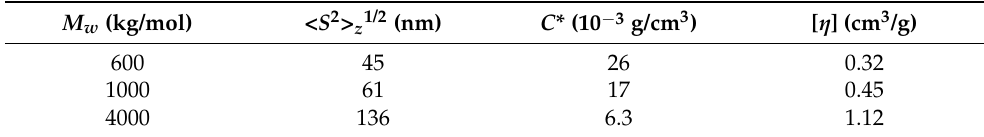
Table 1. The radius of gyration < S 2 > z 1/2 and the overlap concentrations C * for each molecular weight of